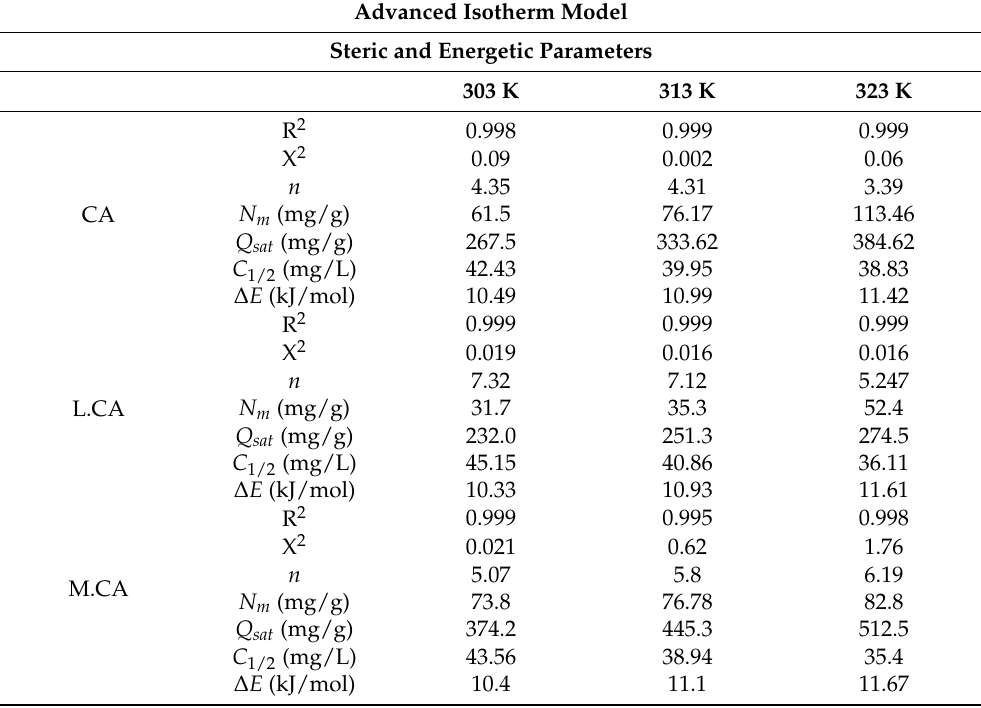
Table 3. The mathematical parameters of the studied advanced isotherm